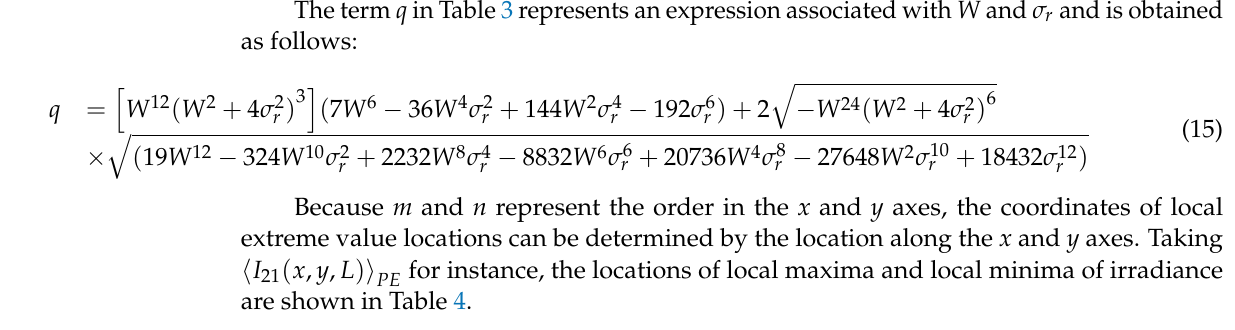
Table 4. Locations of local maxima and minima for TEM 21 Hermite–Gaussian beam. In the presence of pointing error